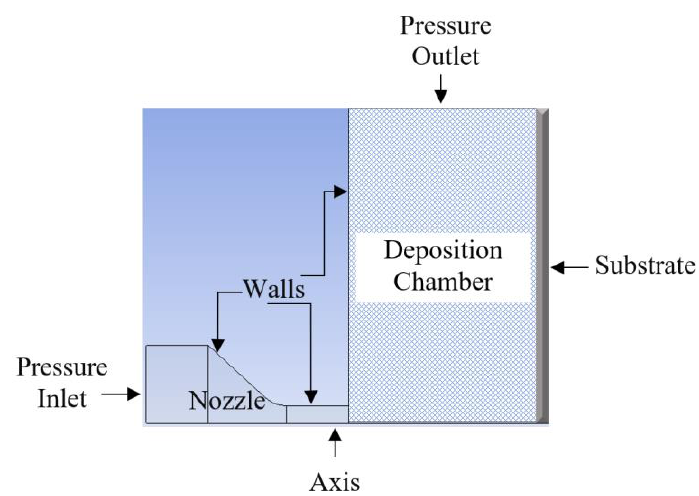
Figure 2. Geometry of the converging-barrel nozzle. Table 1. Main dimensions of the converging-barrel nozzle.